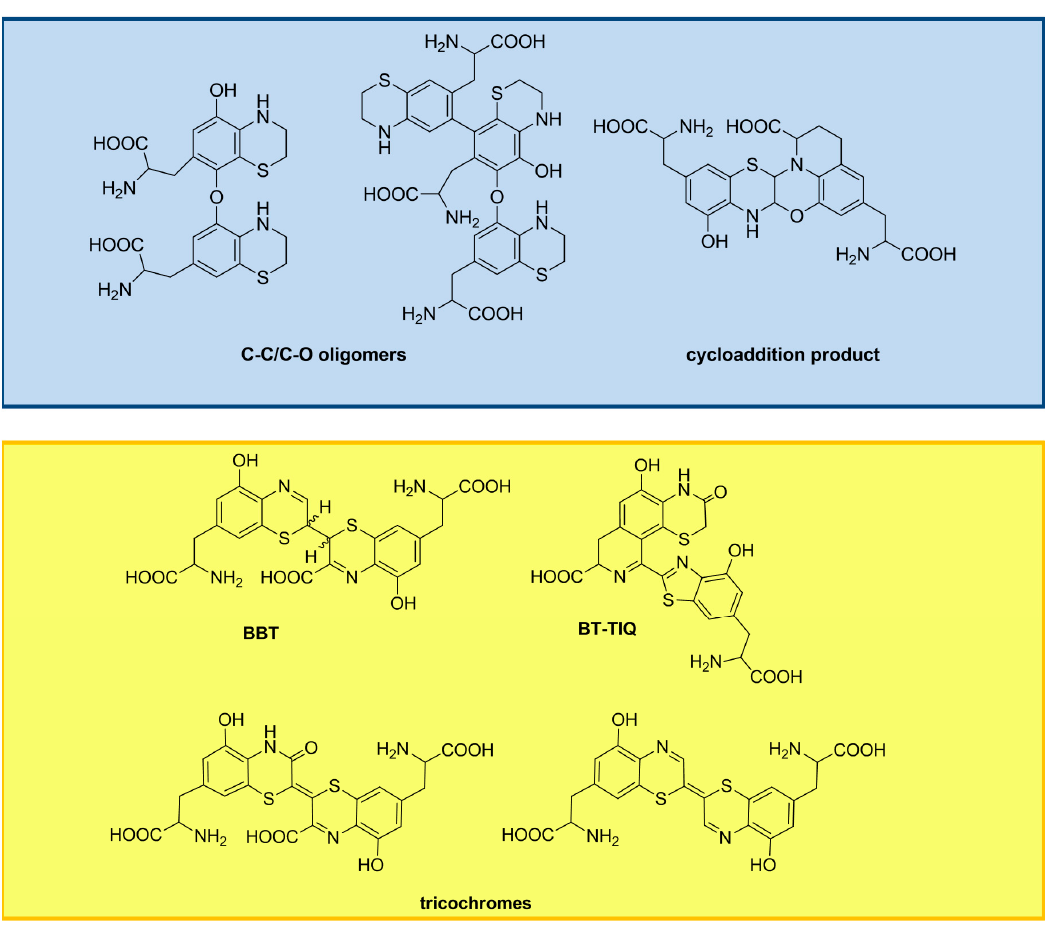
Figure 7. Main oxidation products of BTZ (blue box) and BTZCA (yellow box).